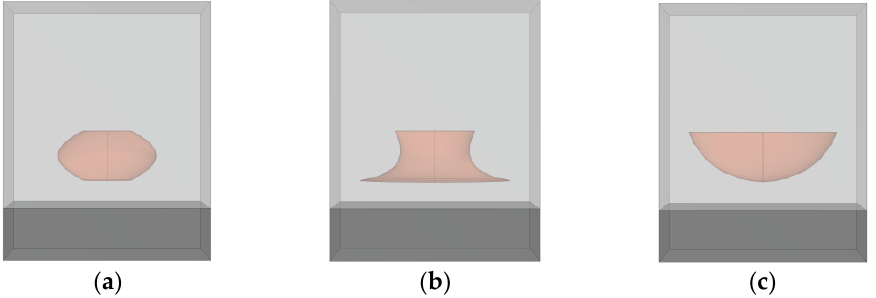
Figure 2. Schematic diagram of the structures, ( a ) Structure 1; ( b ) Structure 2; ( c ) Structure 3.